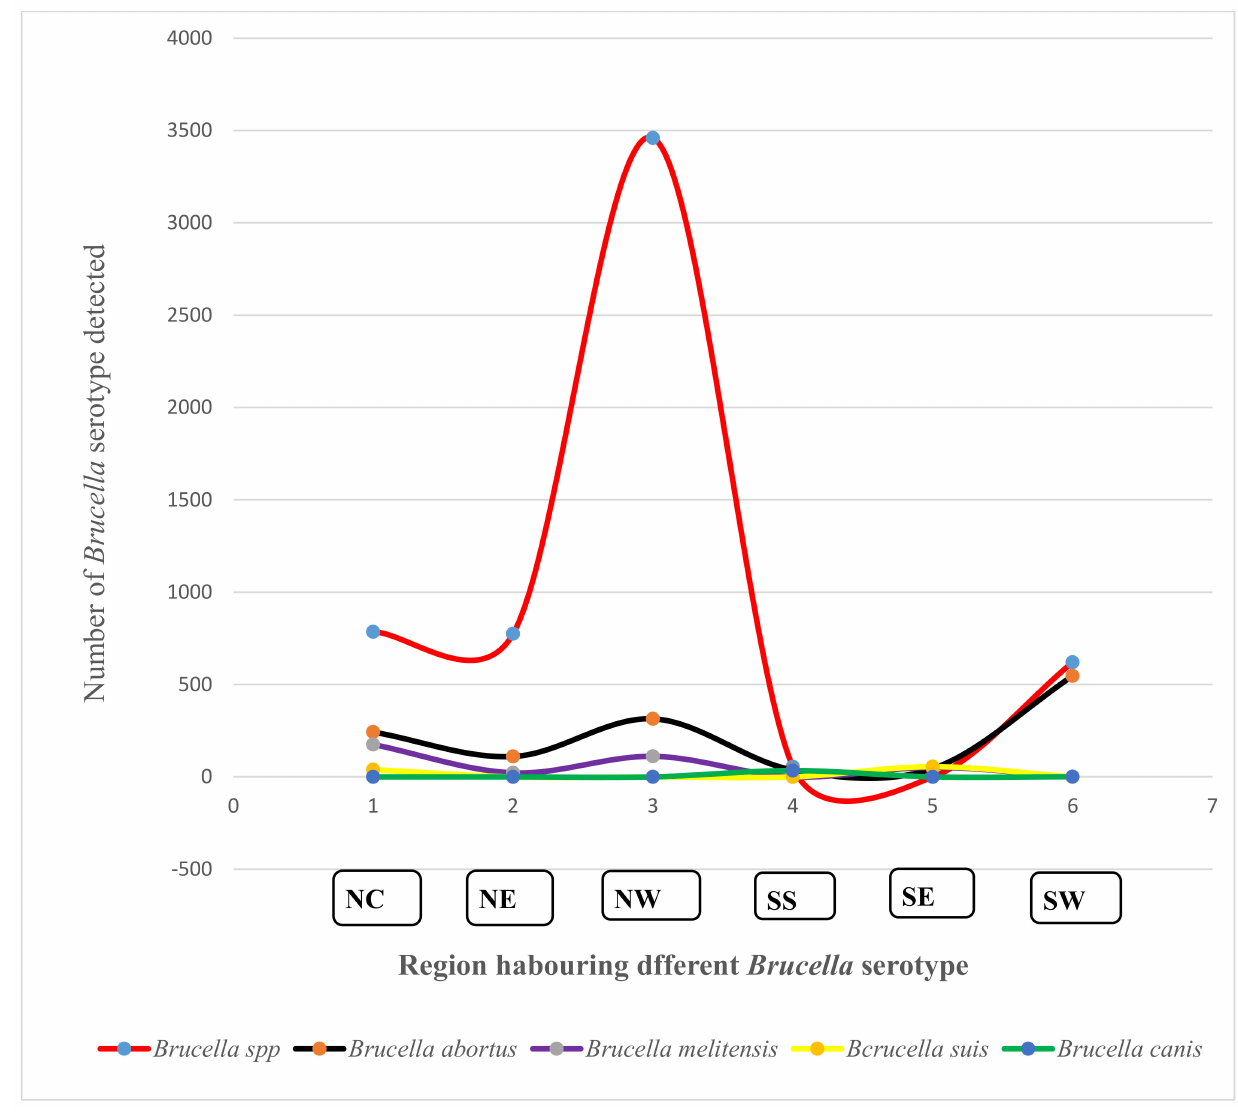
Figure 4. Distribution of prevailing Brucella serotypes from domestic animals reported from the six regions of Nigeria